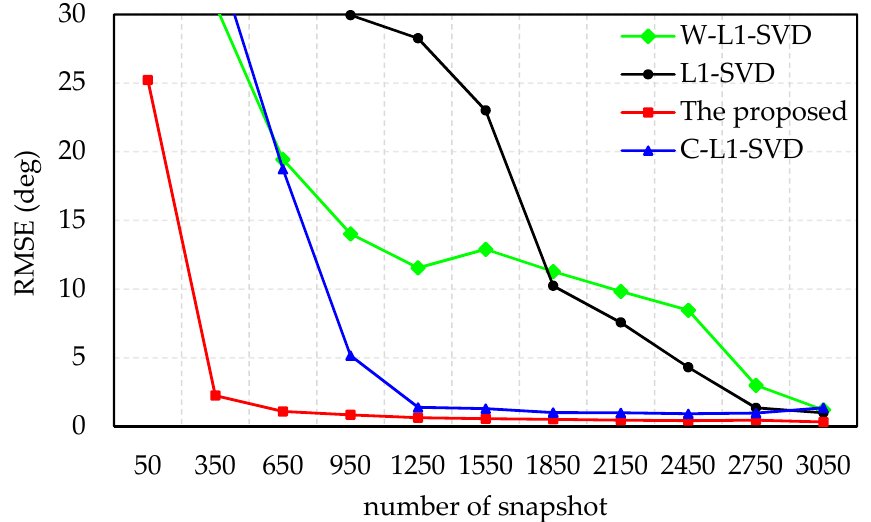
Figure 5. RMSE of the DOA estimates versus number of snapshots with − 12 dB SNR.